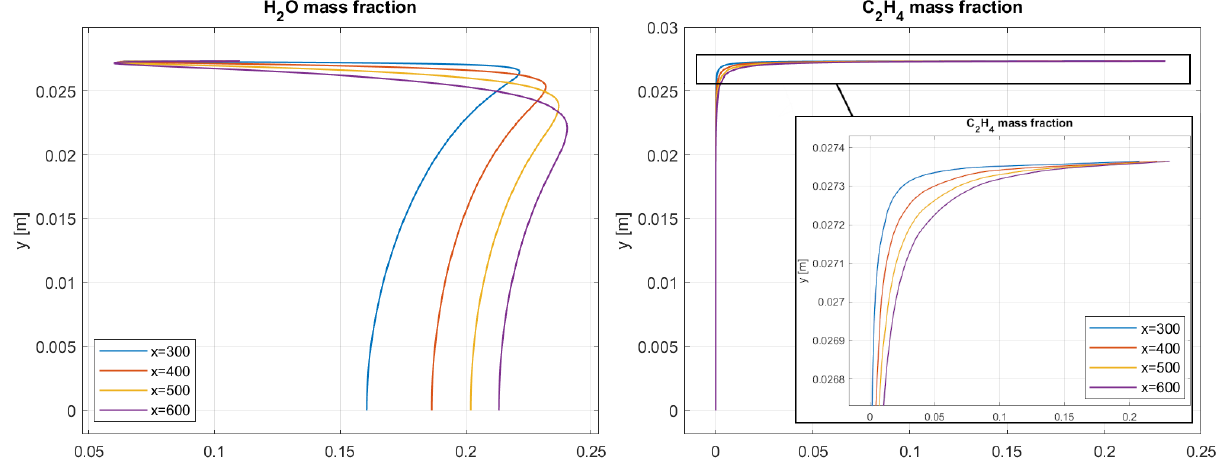
Figure 12. H 2 O 2 mass fraction ( left ) and C 2 H 4 mass fraction ( right ) for Test 7.